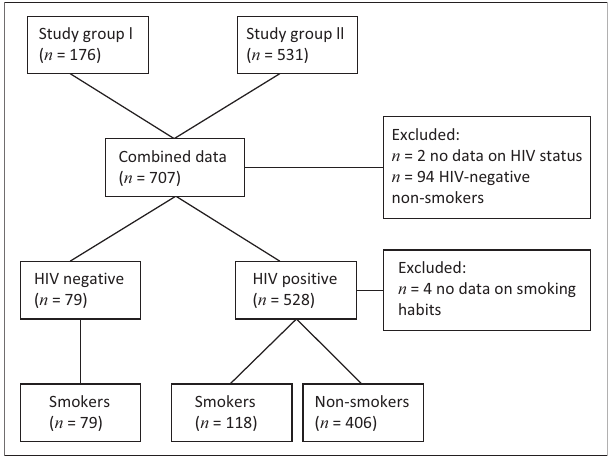
FIGURE 1: Flow diagram of study TABLE 1: Baseline characteristics of the study population stratified by smoking. Characteristics